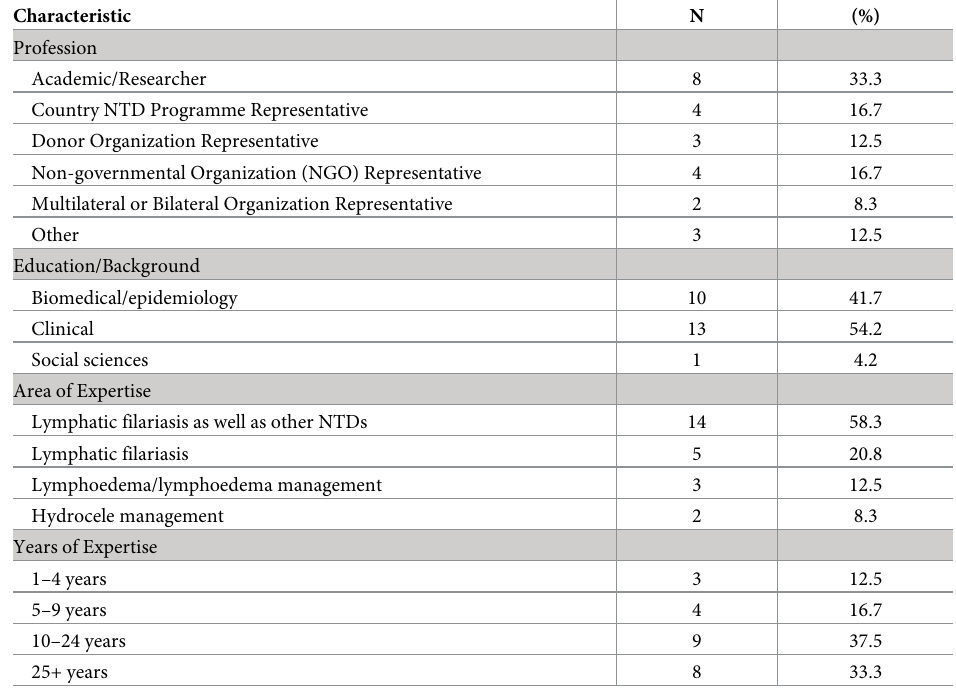
Table 2. Delphi panel composition (N =